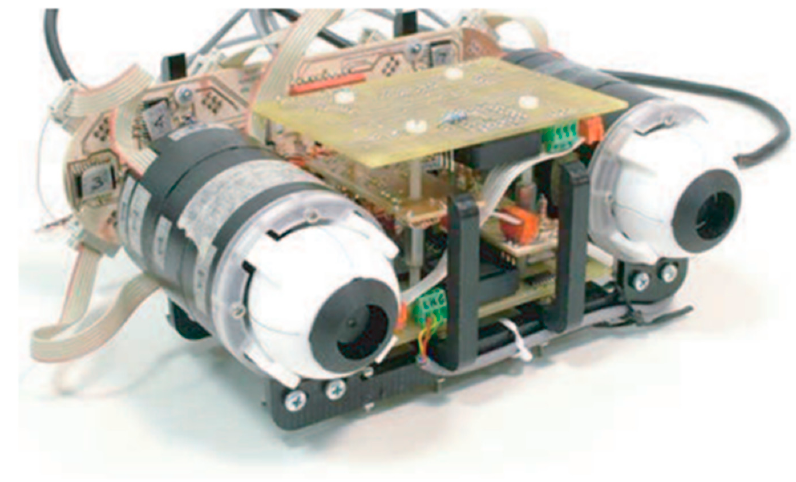
Figure 8. The eye model of a humanoid robot developed by Cannata and Maggiali. Copyright citation: This image is licensed by IEEE.